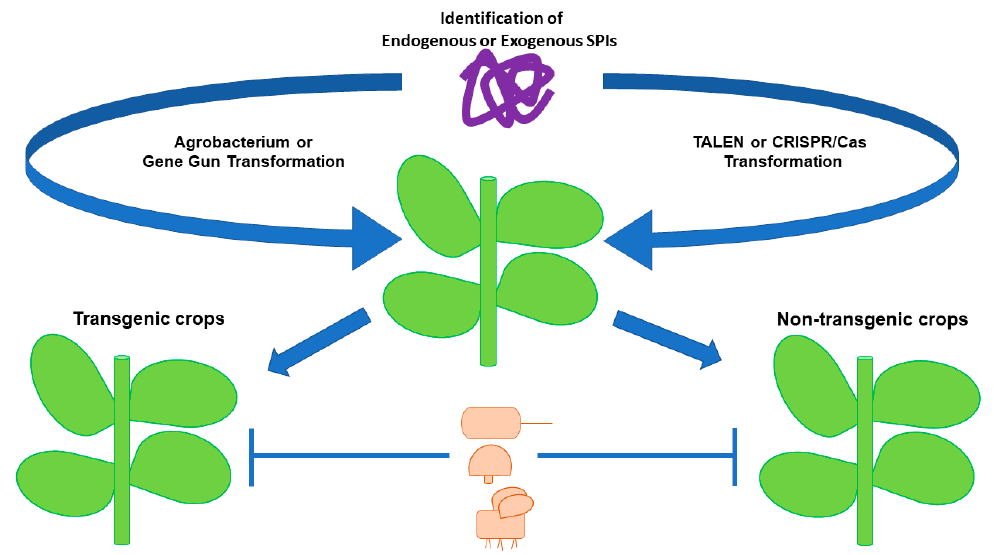
Figure 2. Serine proteases inhibitors identified in plants (endogenous SPIs) or in other organisms (exogenous SPIs) can be introduced by conventional transformation ( Agrobacterium tumefaciens